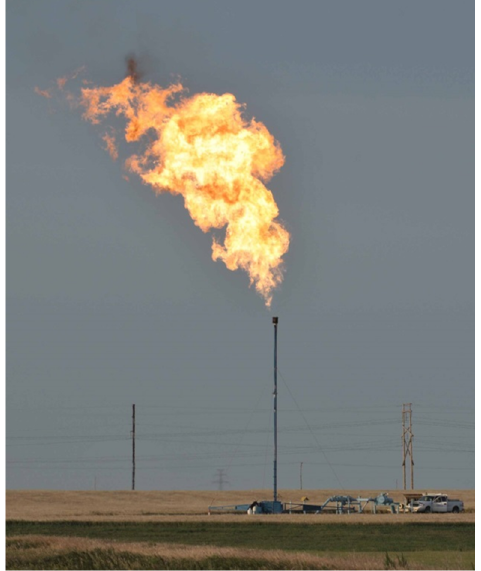
Figure 1. Large quantities of radiant energy are produced by gas flares.